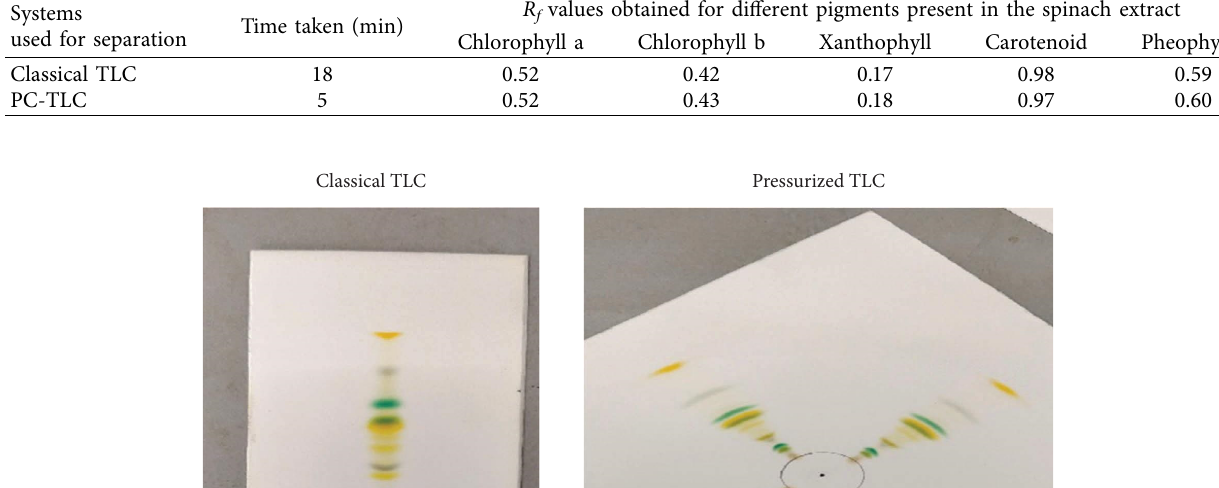
Table 4: Separation of pigments from the extract of spinach leaves by both methods. Systems